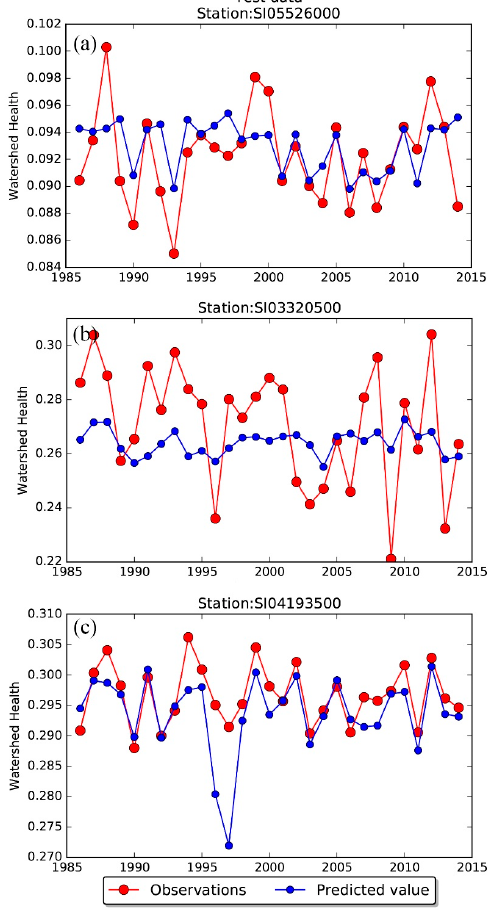
Figure 2. Time series comparison of reference watershed health values inferred from measurements as in Mallya et al. [48] versus predicted watershed health (with respect to SSC) using a random forest model at USGS-NAWQA stations ( a ) 05526000 Iroquois River near Chebanese, IL, ( b ) 03320500 Pond River near Apex, KY, and ( c ) 04193500 Maumee River at Waterville, OH that were used in the test set. Only values for the period 1986–2014 are shown for brevity.